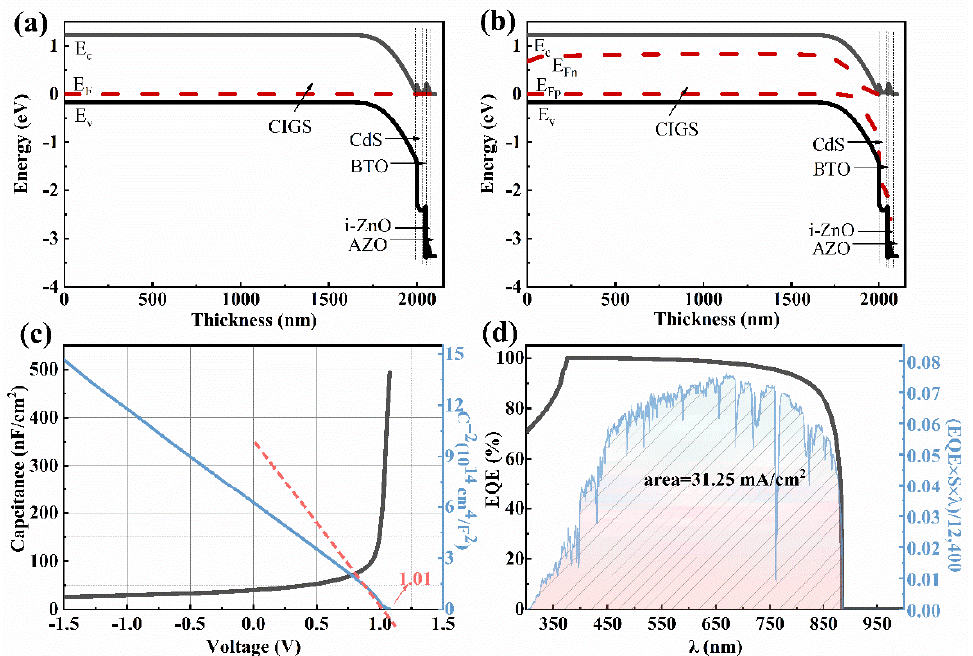
Figure 10. The energy band diagram, C - V , and EQE curve of the ferroelectric-coupled CIGS solar cell with a device structure of Mo/CIGS/CdS/BTO/i-ZnO/AZO: ( a ) under dark, ( b ) under the AM1.5 G light illumination, ( c ) C - V curve and C −2 - V curves, and ( d ) EQE curve and the J sc value from the integral curve based on the expression EQE × S × λ 12,400